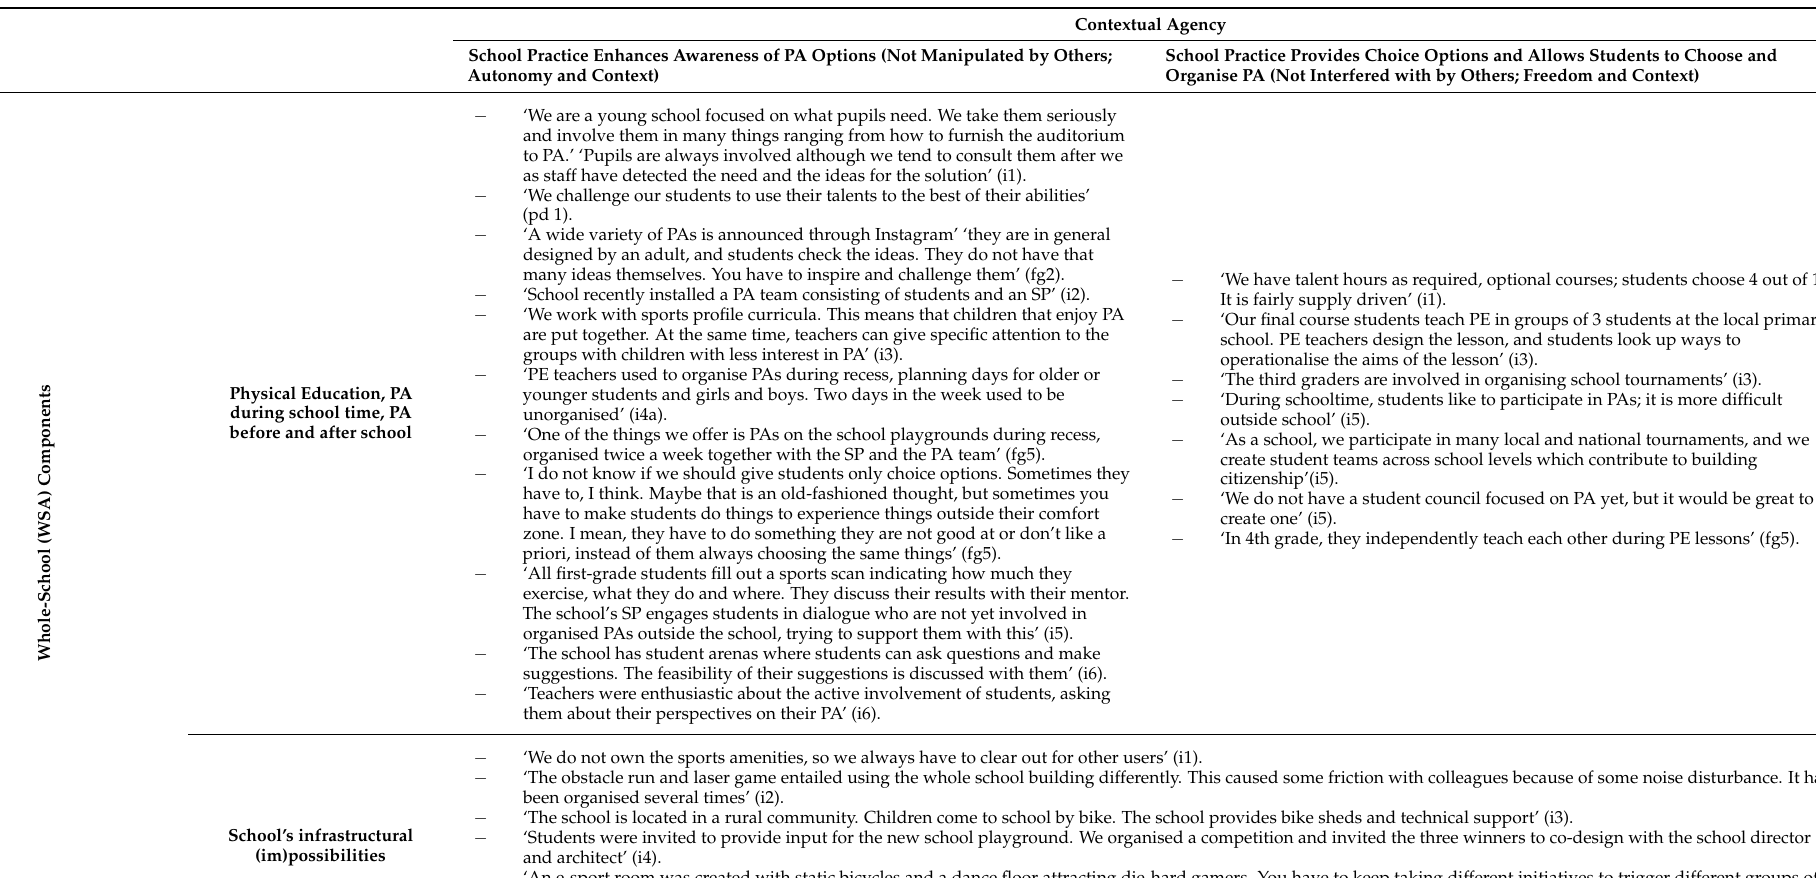
Table 1. Quotes attributed to the operationalisation of the whole-school components and the contextual dimensions of